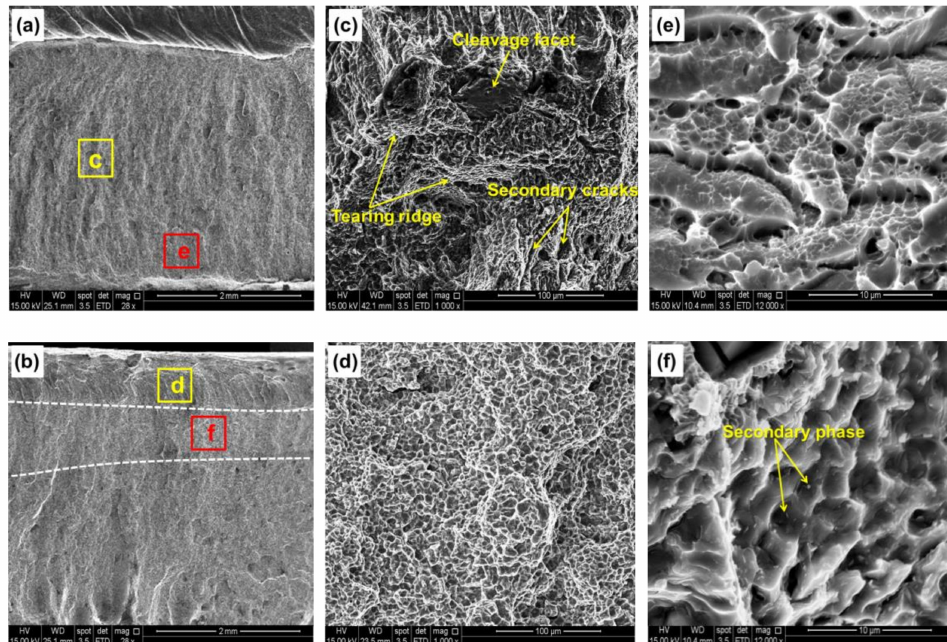
Figure 8. Tensile facture morphologies of welded joints: ( a ) joint 4, ( b ) joint 5, ( c ) magnification of yellow rectangle c in ( a ), ( d ) magnification of yellow rectangle d in ( b ), ( e ) magnification of red rectangle e in ( a ), and ( f ) magnification of red rectangle f in ( b